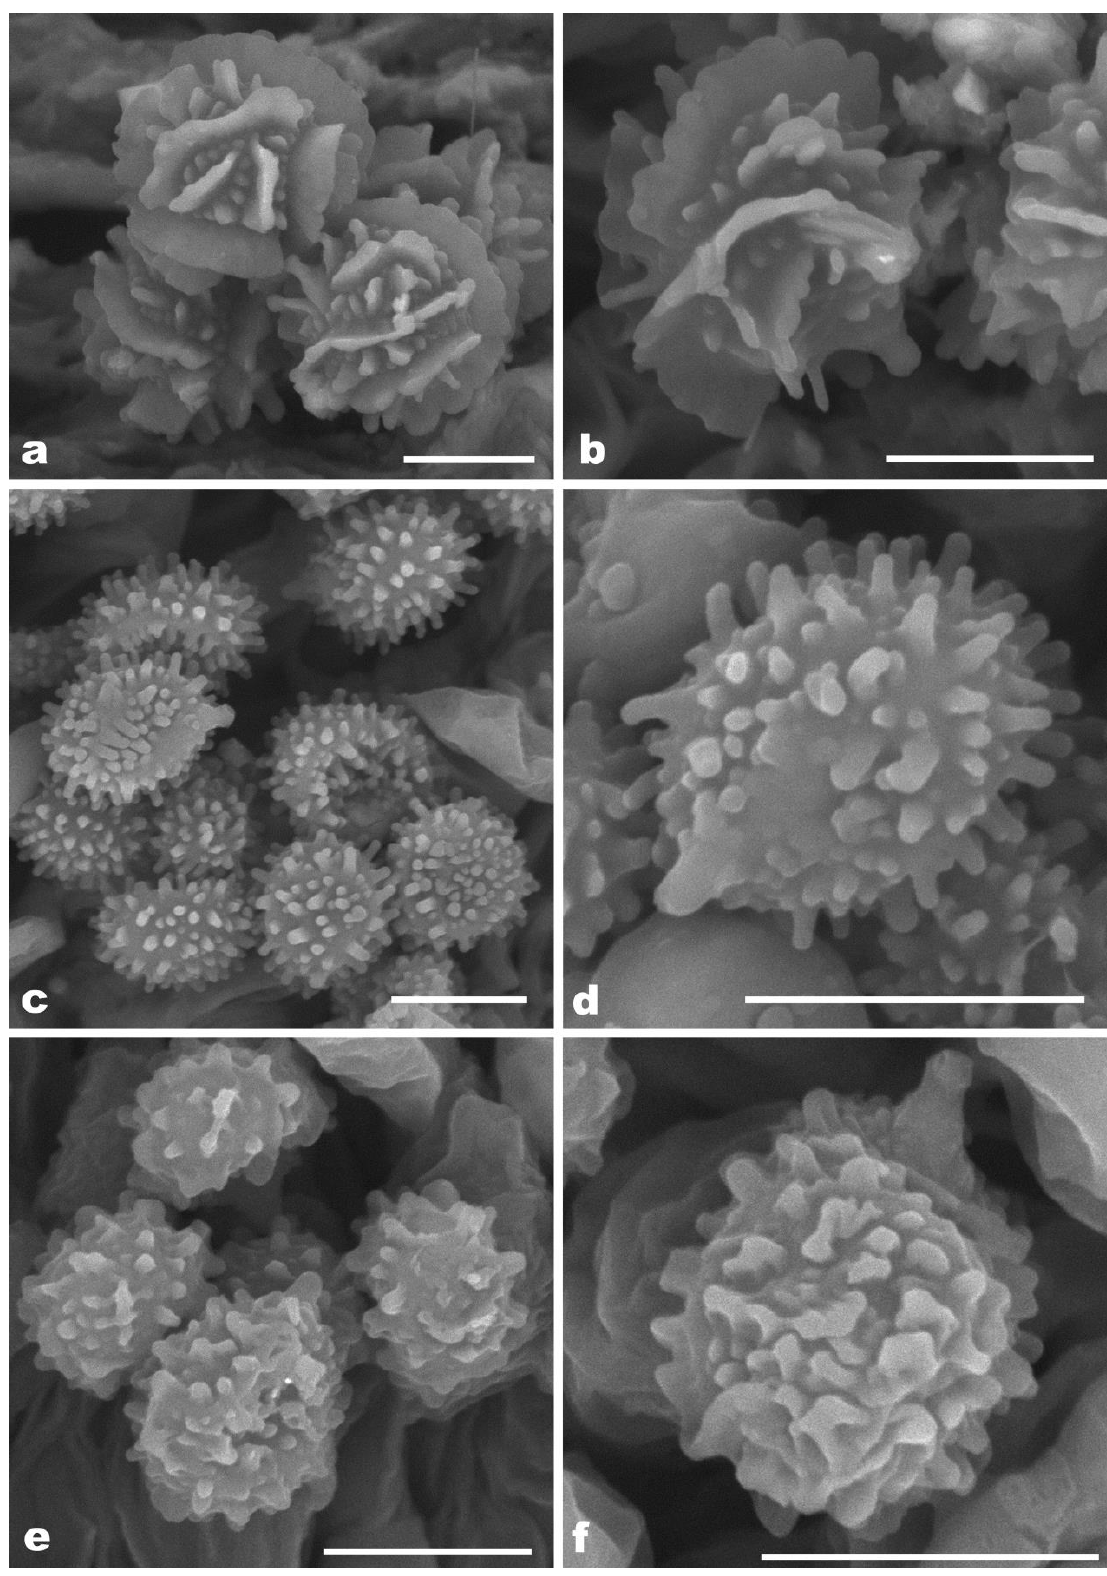
Figure 3. Basidiospores of Russula sect. Ingratae species from herbarium materials under SEM. ( a , b ) R. fujianensis (FHMU975, holotype); ( c , d ) R. oraria (FHMU5355, holotype); ( e , f ) R. rufobasalis (FHMU827). Bars: 5 μm. Photos: Y.X. Han.